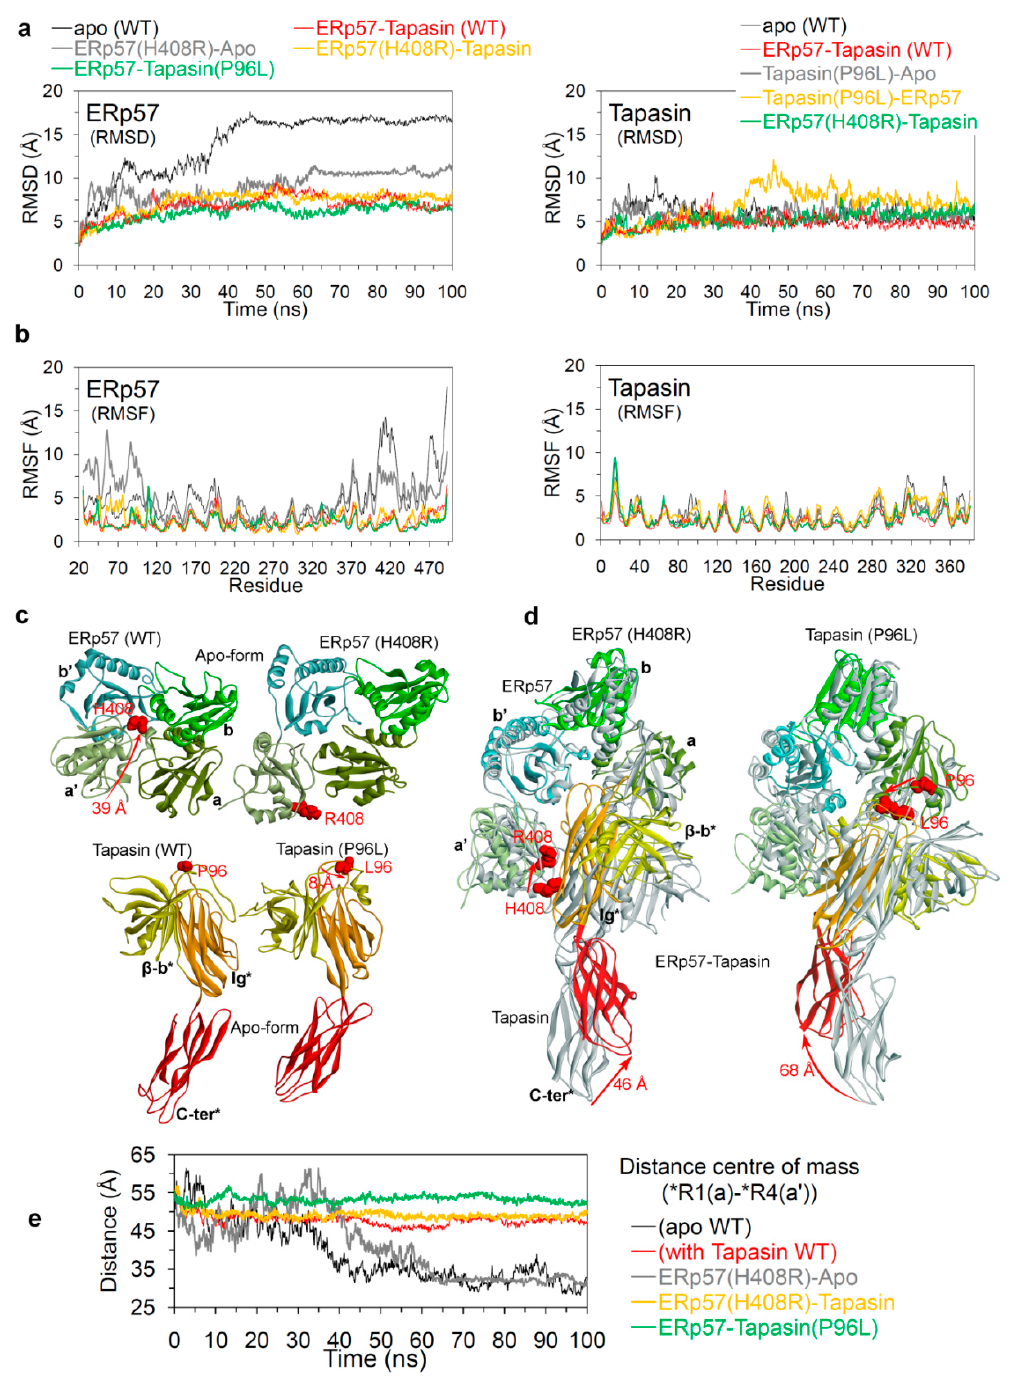
Figure 5. Structural analysis of mutant ERp57(H408R) and tapasin(P96L) systems in comparison with the wild-type systems. ( a ) RMSD of all-atoms (excluding hydrogen atoms) of ERp57 and tapasin from wild-type and mutant systems. ( b ) The residual fluctuations (RMSF) of each residue of ERp57 and tapasin in simulated wild-type and mutant systems. ( c and d ) Structure conformations or domain motions of ERp57 and tapasin structures in different simulated systems. ( e ) Distance of mass centre between a and a’ domains in ERp57 structure plotted as a function of time.